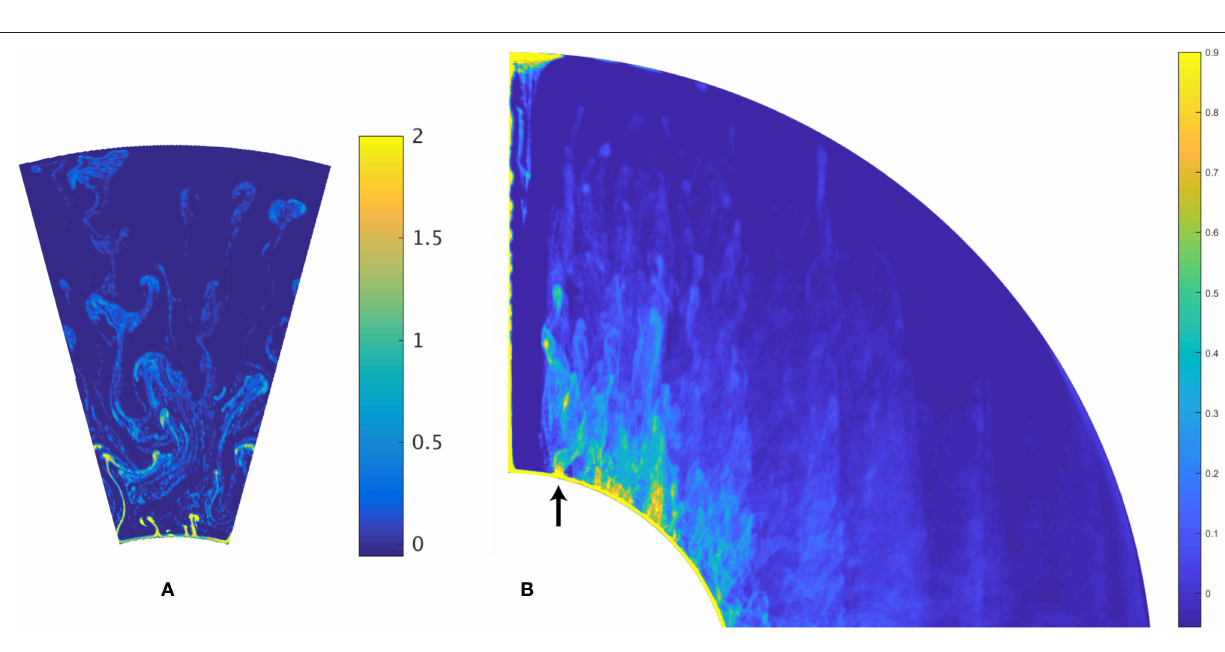
0.066 and Ro 4.4 10 − 4 . (B) Azimuthal average of the chemical field = = ×